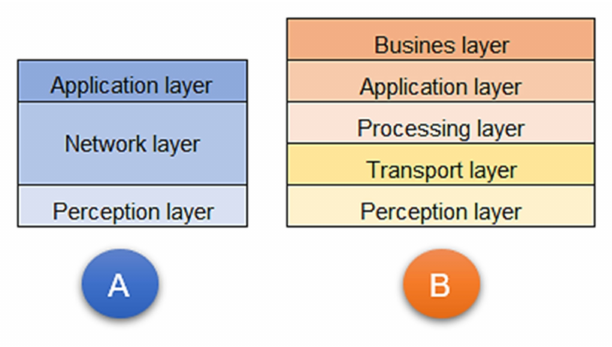
Figure 1. IoT architecture based on layering model.